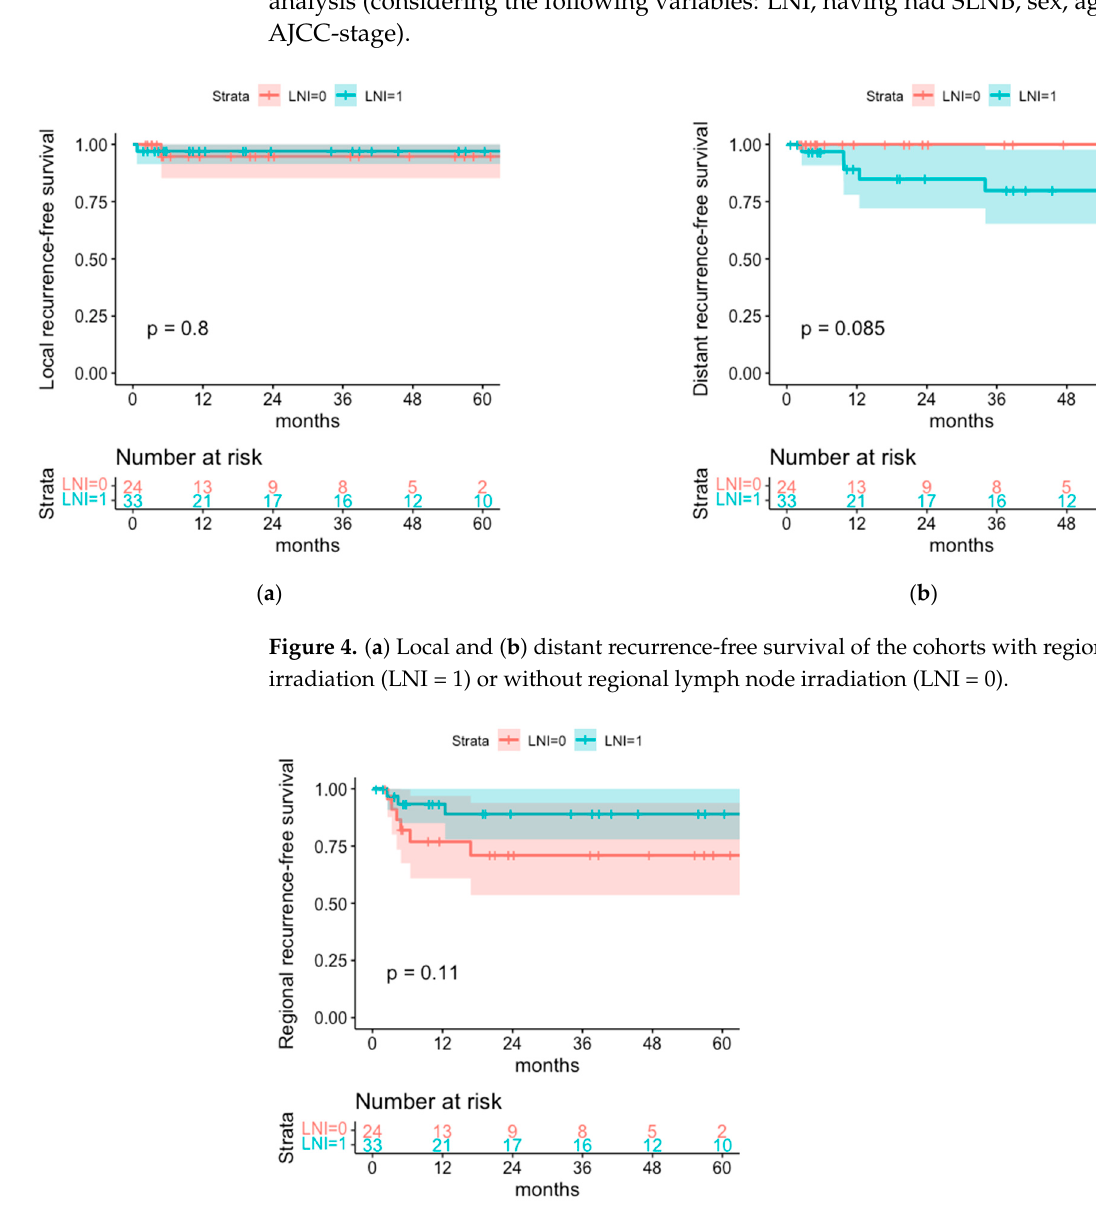
Figure 5. Regional recurrence-free survival of the cohorts with regional lymph node irradiation (LNI = 1) or without regional lymph node irradiation (LNI = 0).